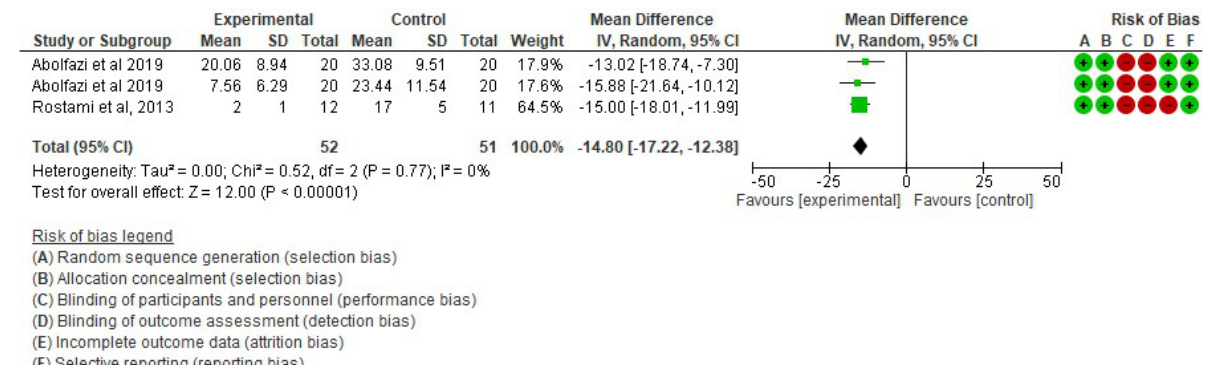
Figure 2. Effect of Mirror Therapy as Measured with DASH: 6–9 weeks post-intervention [38,39].